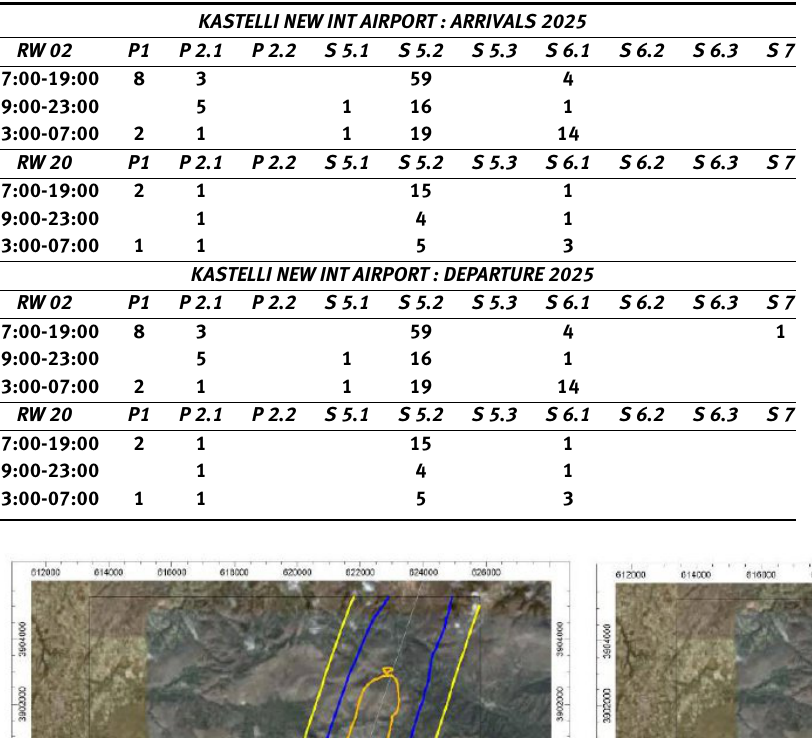
Table 5. Annual average daily aircraft movements (TOffs & landings) at the new Kastelli airport - 2025.